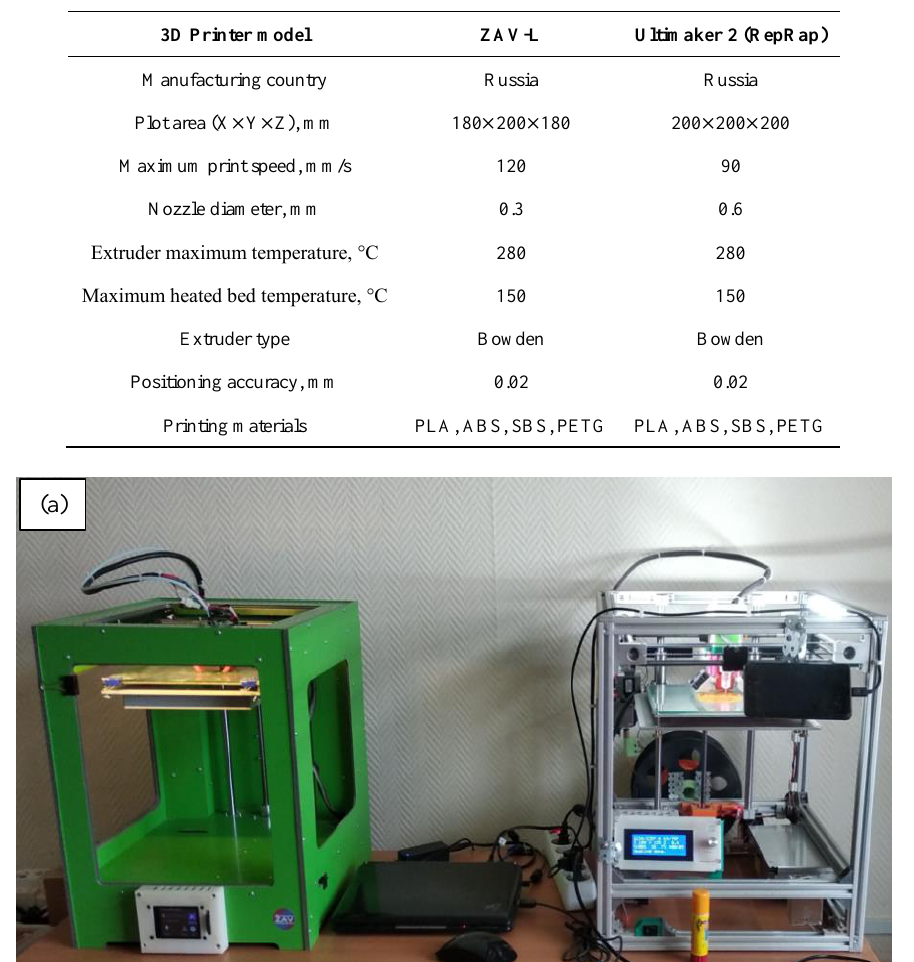
Table 1. Printer